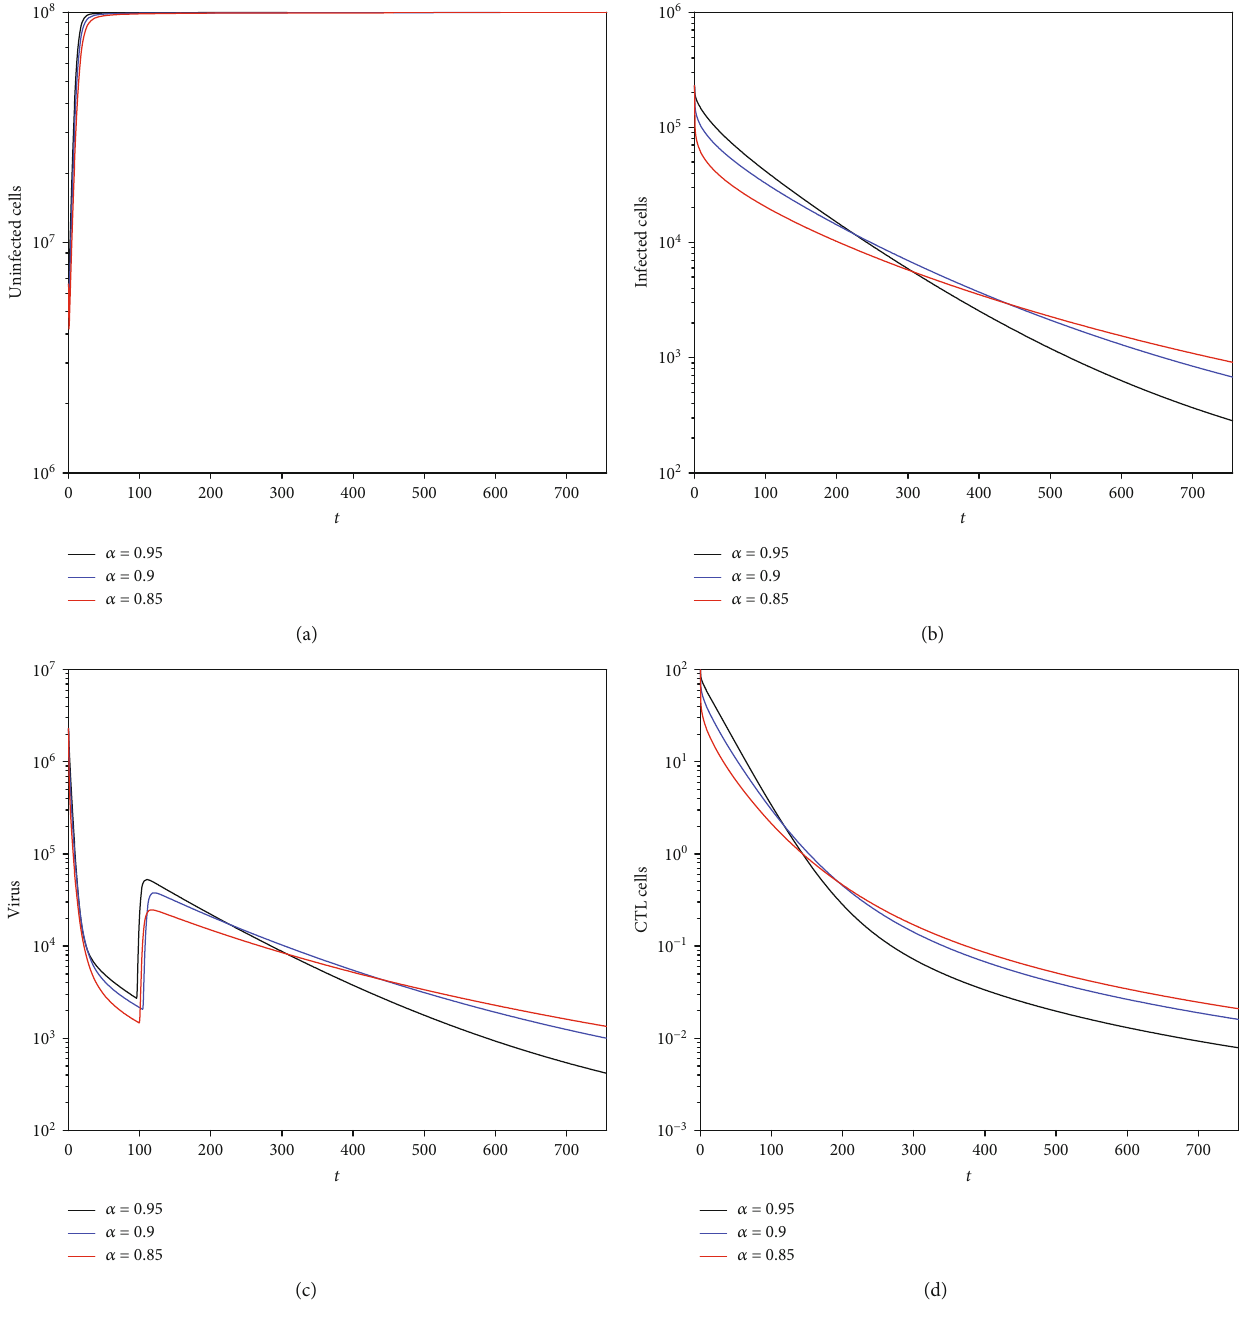
Figure 1: State dynamics of uninfected and infected cells, free virus, and CTL cells with Strategy